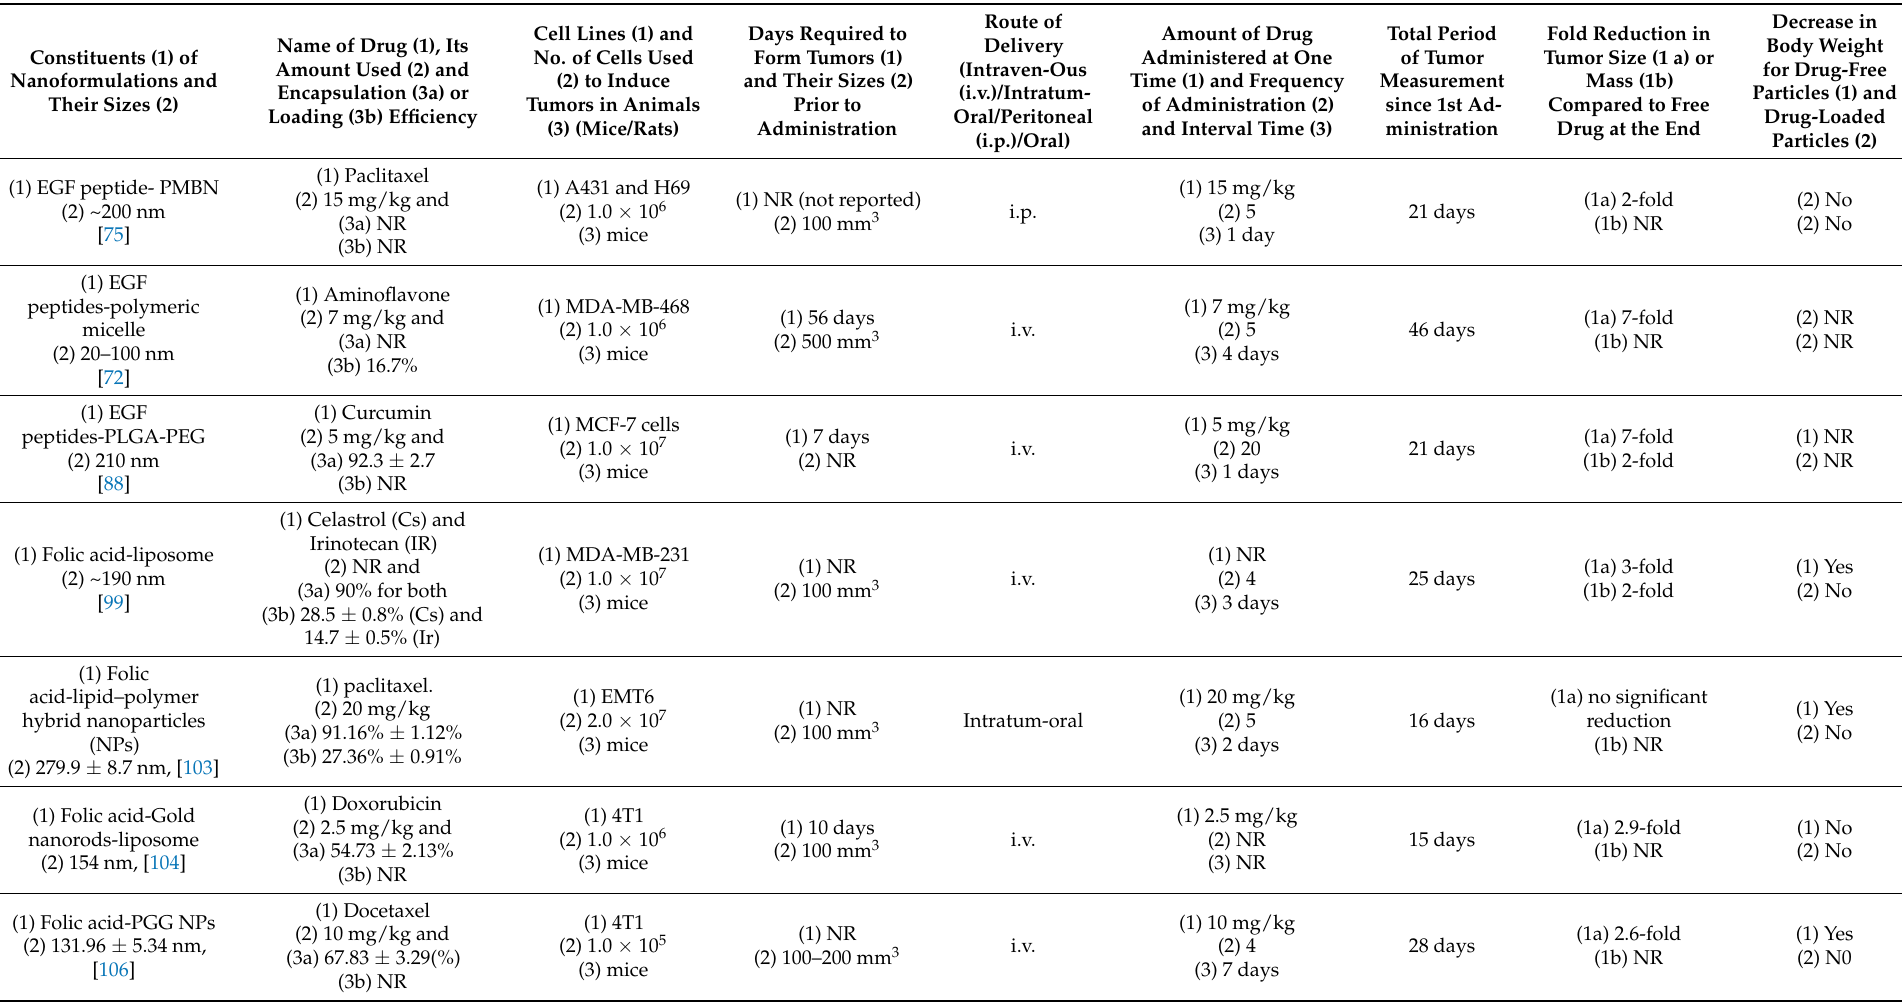
Table 1. Assessment of the antitumor effects of specific receptor-targeting nanoparticles carrying chemotherapy drugs following systemic delivery in animal models of breast cancer.